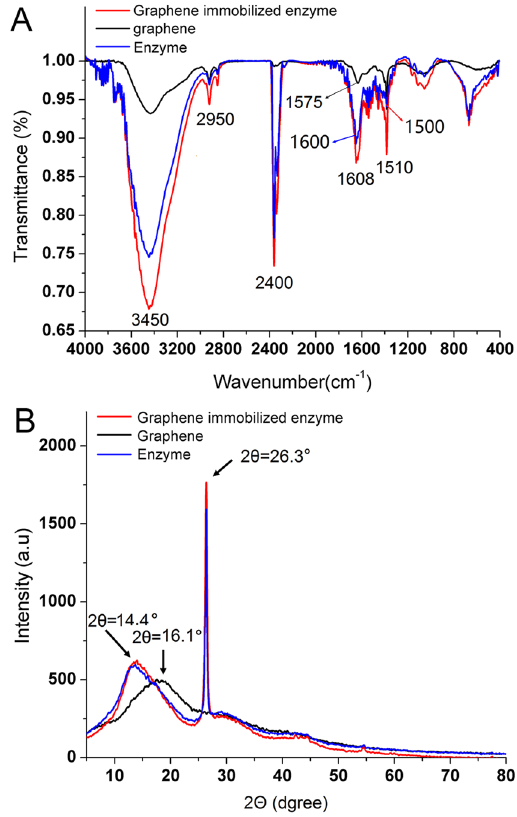
Figure 3. The FT-IR ( A ) and XRD ( B ) spectra of graphene immobilized enzyme, graphene and enzyme. Reaction condition: enzyme solution (20 g/L) was dissolved by disodium hydrogen phosphate-citrate buffer (pH 7); graphene nanoparticles mass (20 mg) was added in 4 mL of enzyme solution and the mixture was stirred at 120 rpm in an incubator shaker for 3 h, reaction temperatures was 50